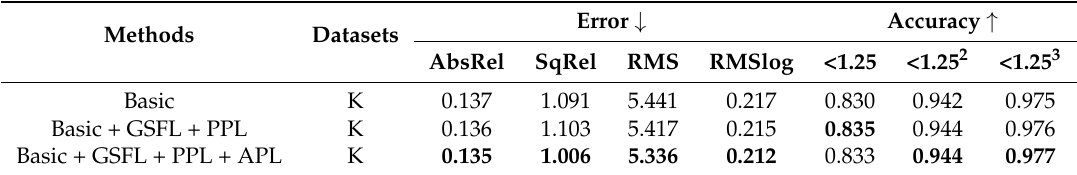
Table 5. The depth ablation experiments are carried out on the KITTI raw data. GSF, PPL, and APL respectively represent the ground self-learning loss, the plane photometric loss and the depth abnormal punishment loss.